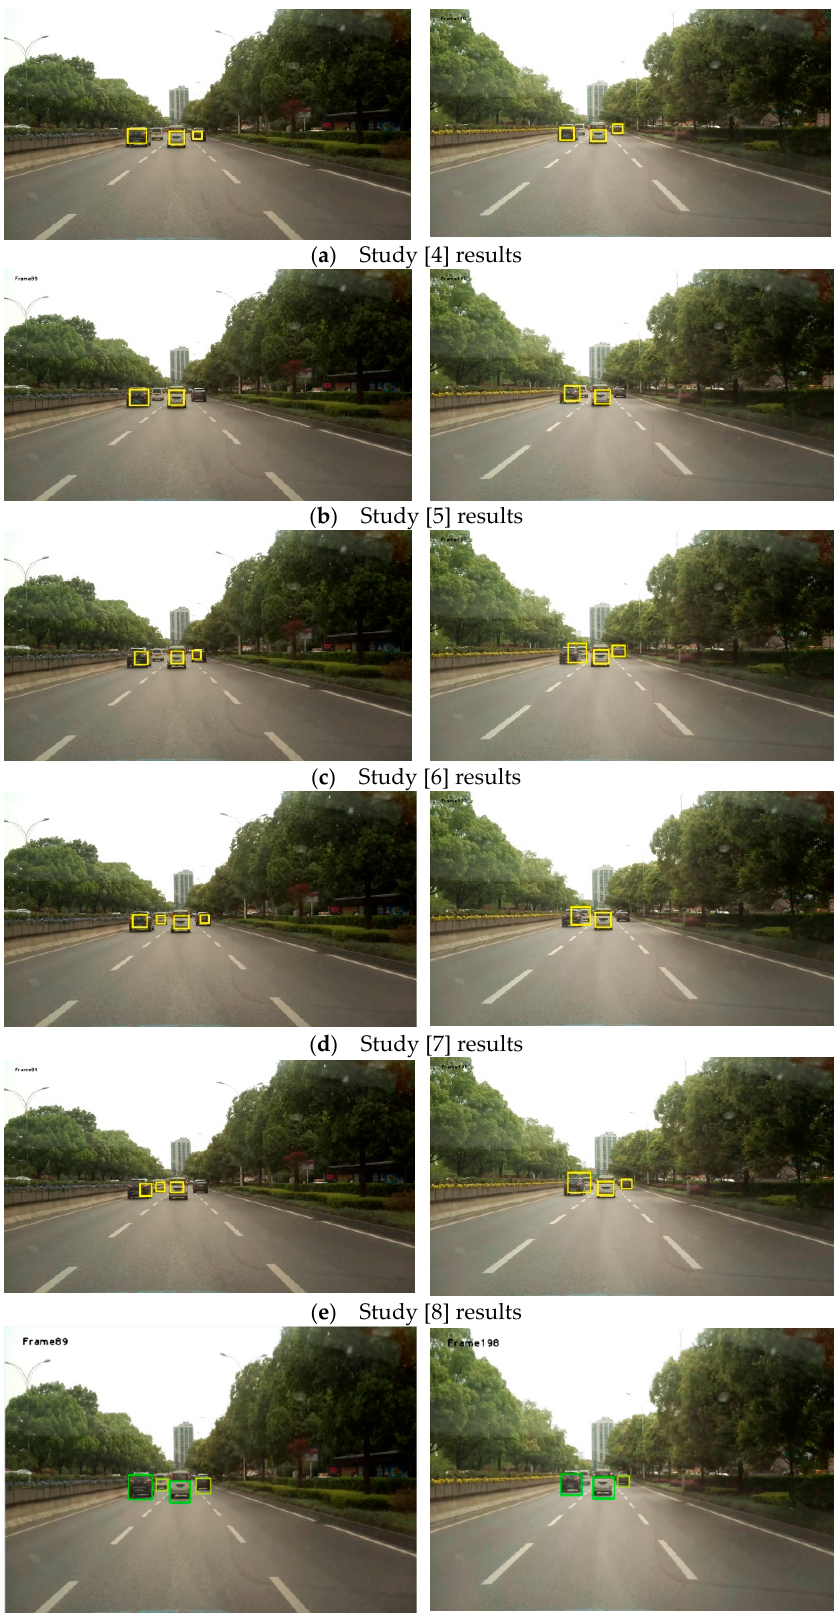
Figure 14. Experimental results of various Figure 14 . Experimental results of various methods.